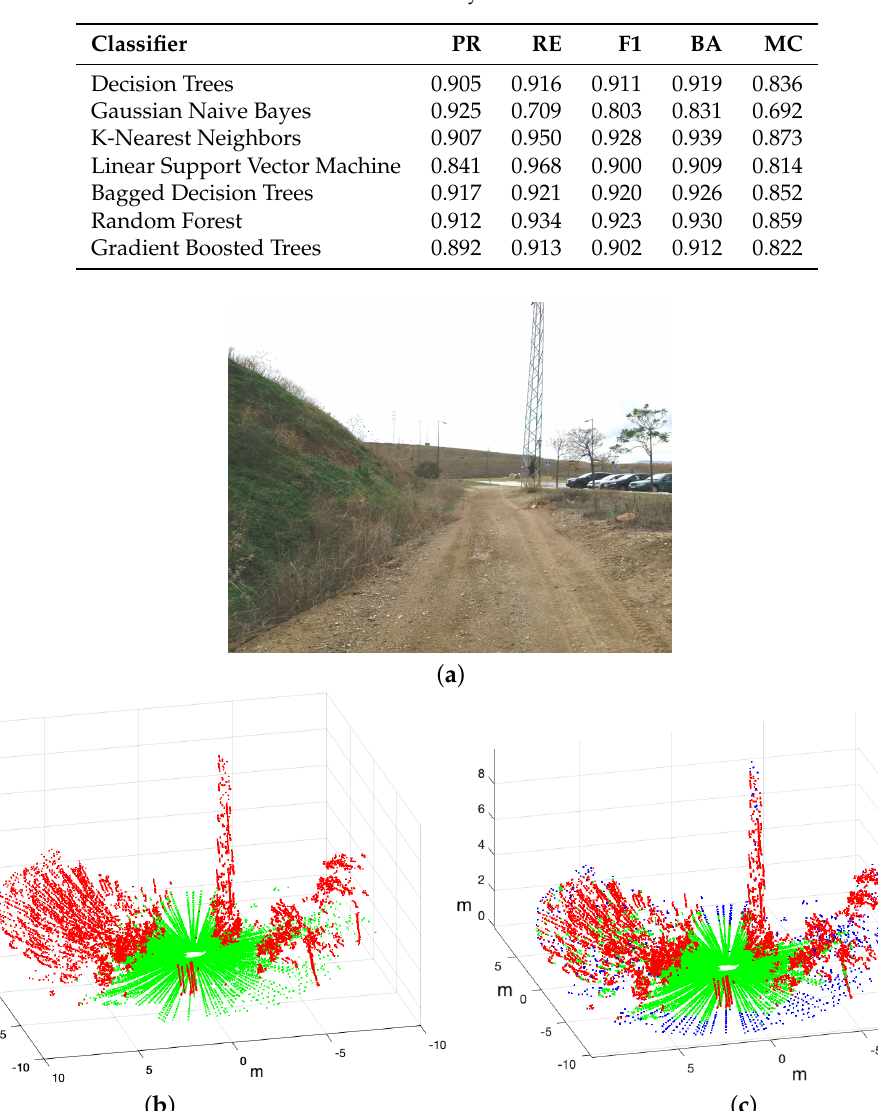
Table 5. Balanced accuracy indices for real data.